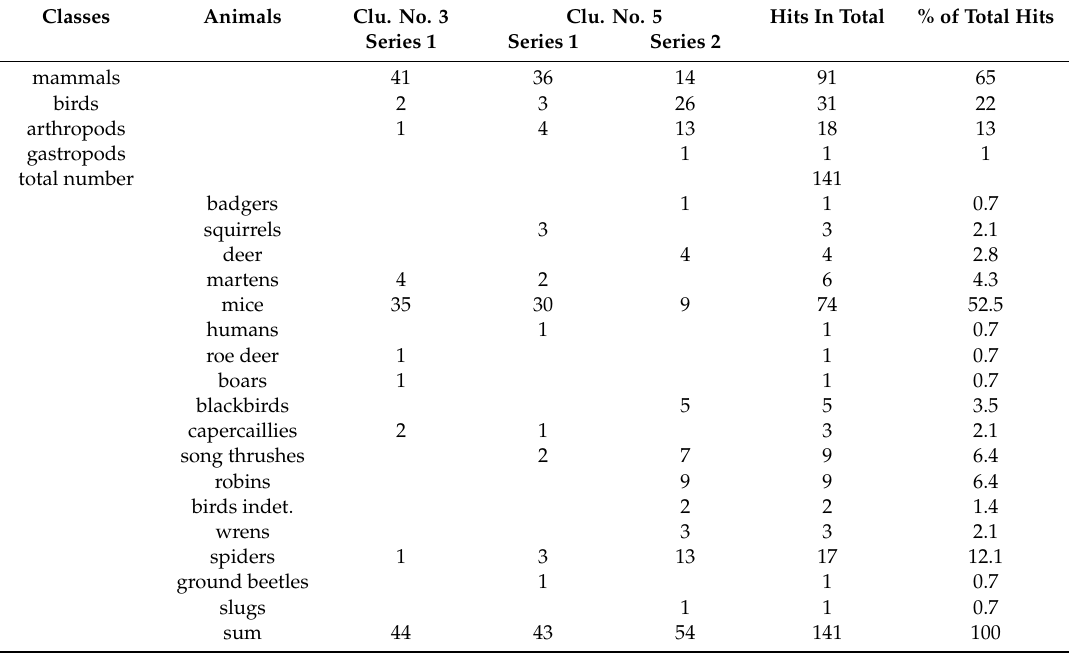
Table 3. Type and number of animals captured by the automatic release of cameras at two sites within the respective months of observation; Clu. No.—cluster number (see Table 1); Series 1: 3